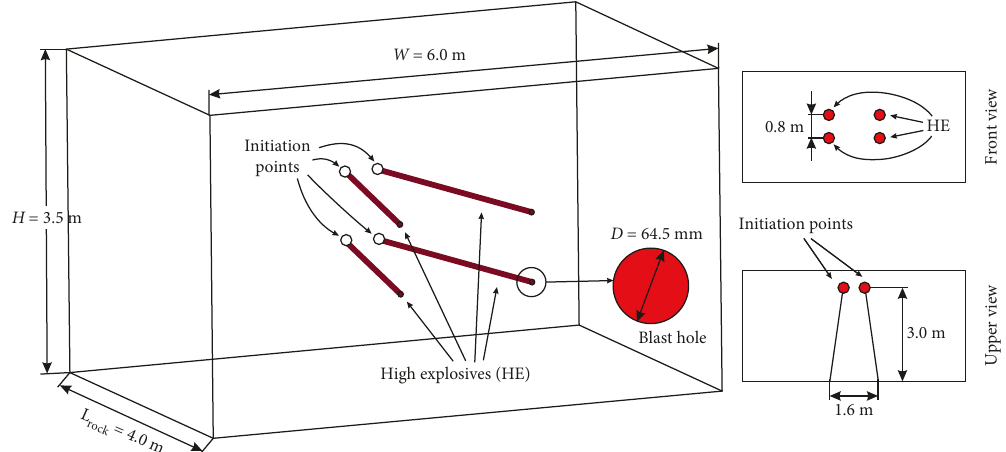
Figure 2: Model of the mining face (submodel) with initial-boundary